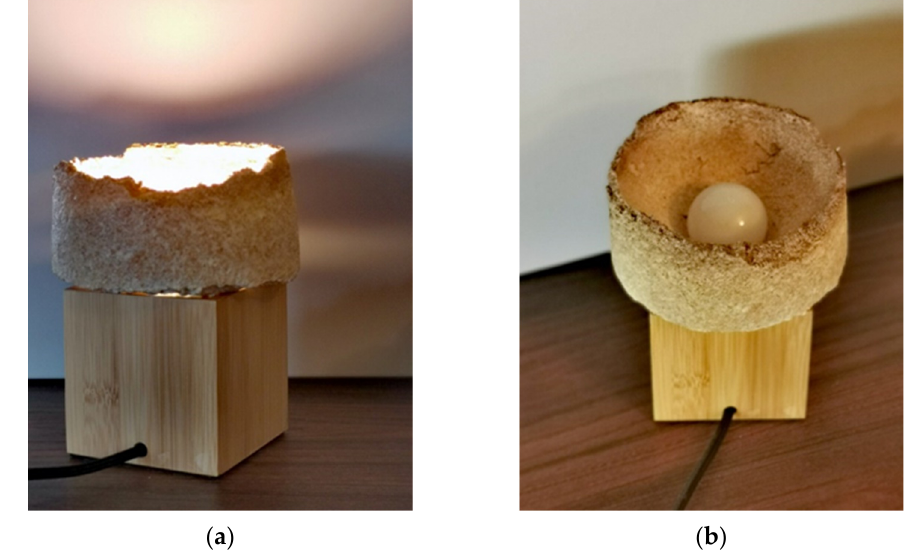
Figure 11. Mycelium-based light fixture: ( a )—with lamp on, ( b )—general appearance (design and photo: A. Bonenberg).